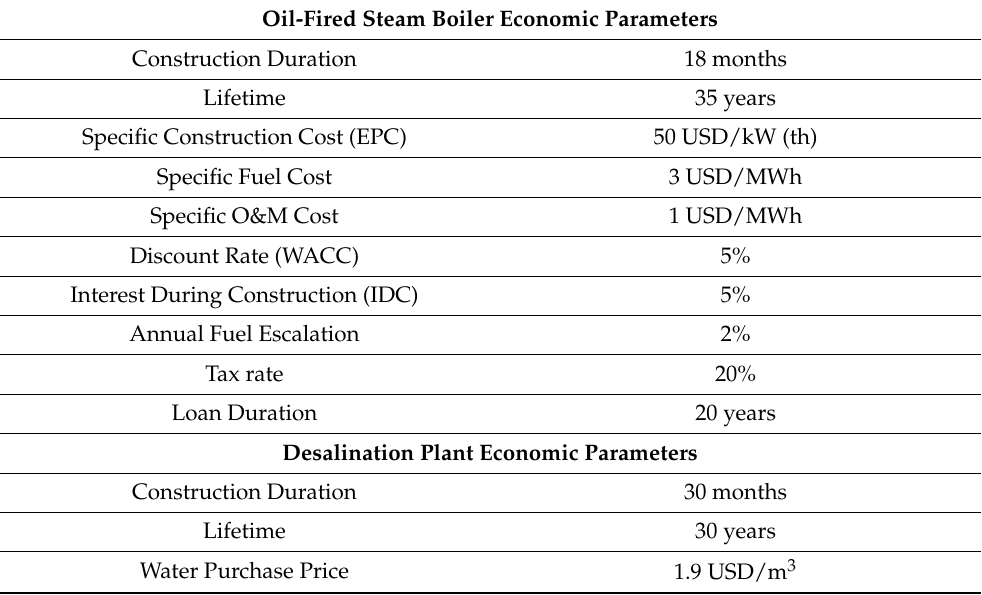
Table 9. Economic parameters for oil-fired boiler and desalination